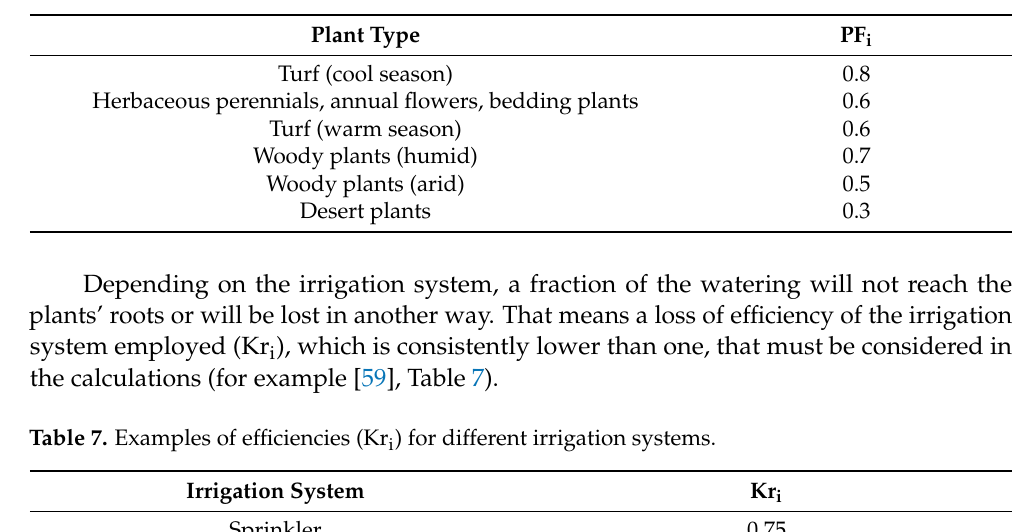
Table 6. Examples of plant factors (PF i ) for some different plant types.